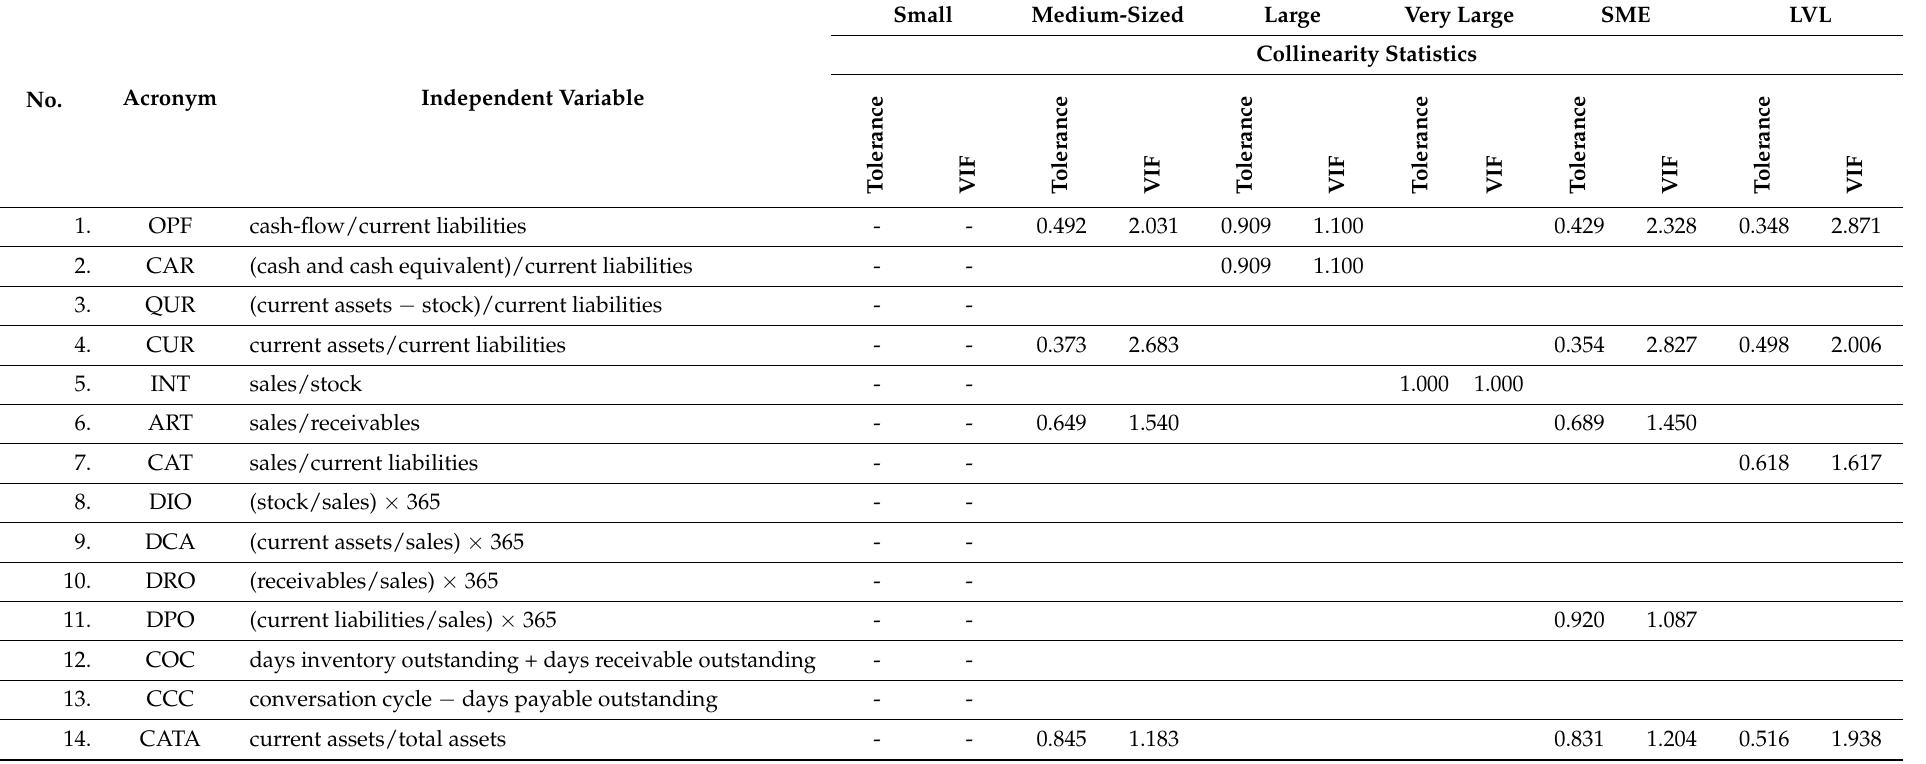
Table A3. VIF for the selected subsamples in the Czech